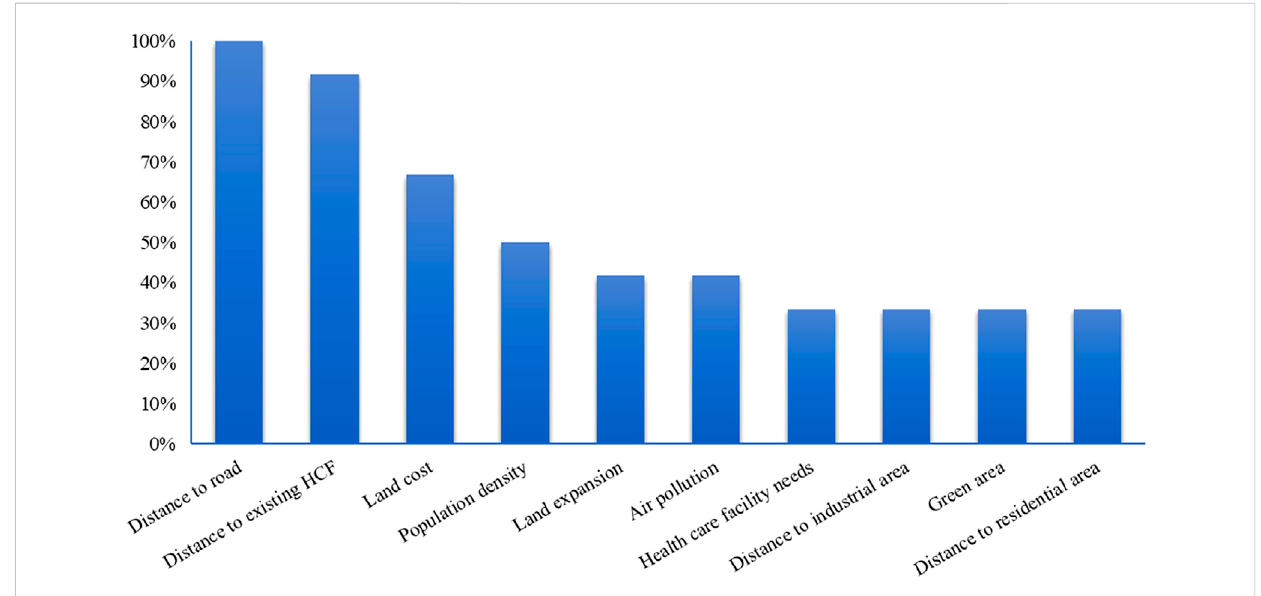
FIGURE 5 Frequency diagram of the preliminary evaluation indices.